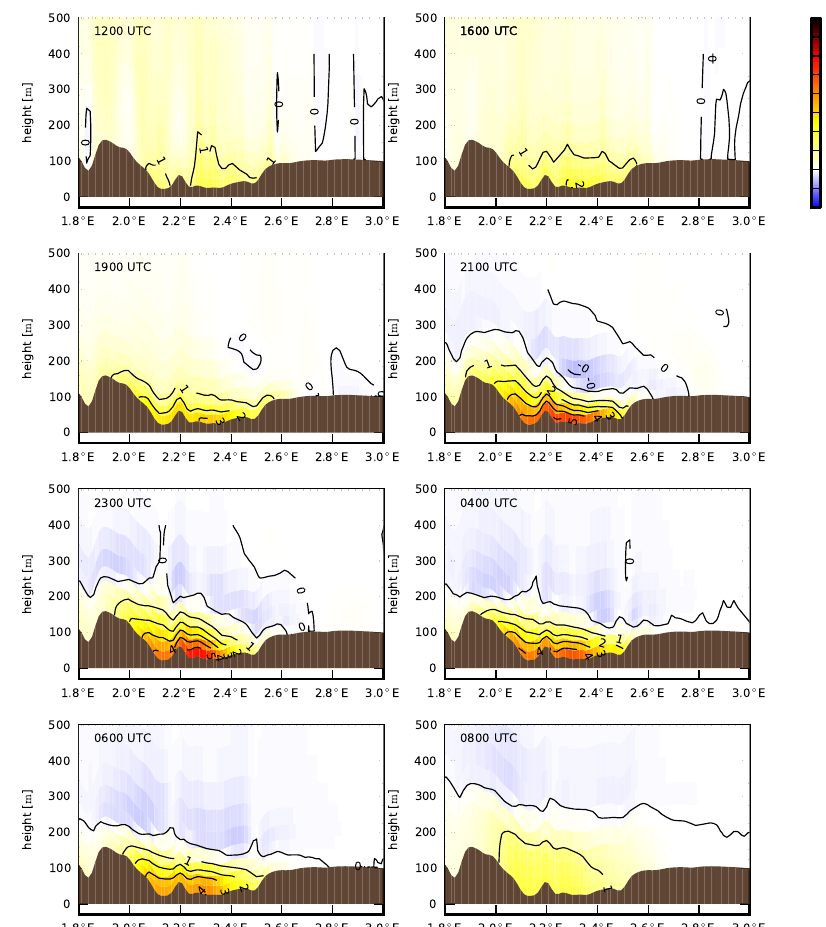
Fig. 9. 5-day averaged diurnal cycle run through Paris along the wind direction. The city centre is indicated with a red